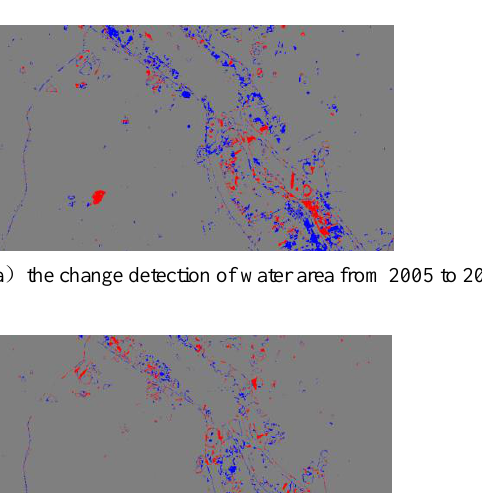
Fig.6. the result of the vector layer of water area from 2005 to 2009